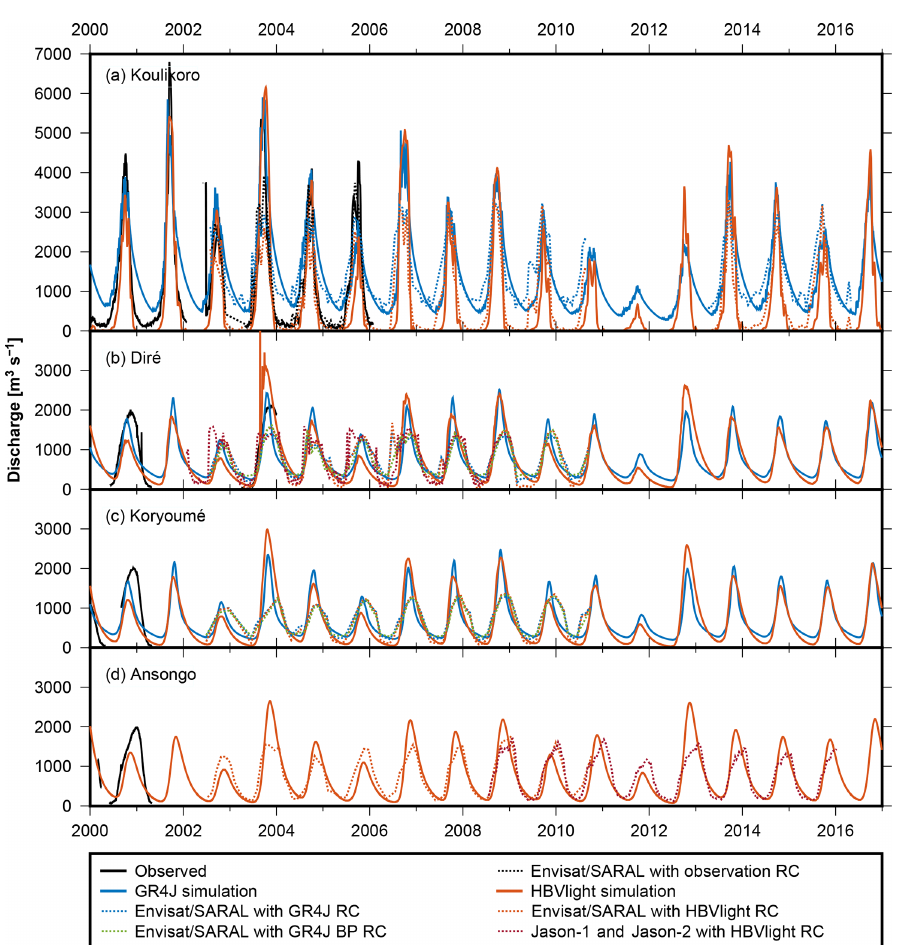
Figure 9. Altimetric discharge (dotted lines) together with observed and simulated discharge (solid lines). RC is the rating curve; BP is the break point. The Kandadji station is omitted due to the insufficient amount of altimetry and discharge